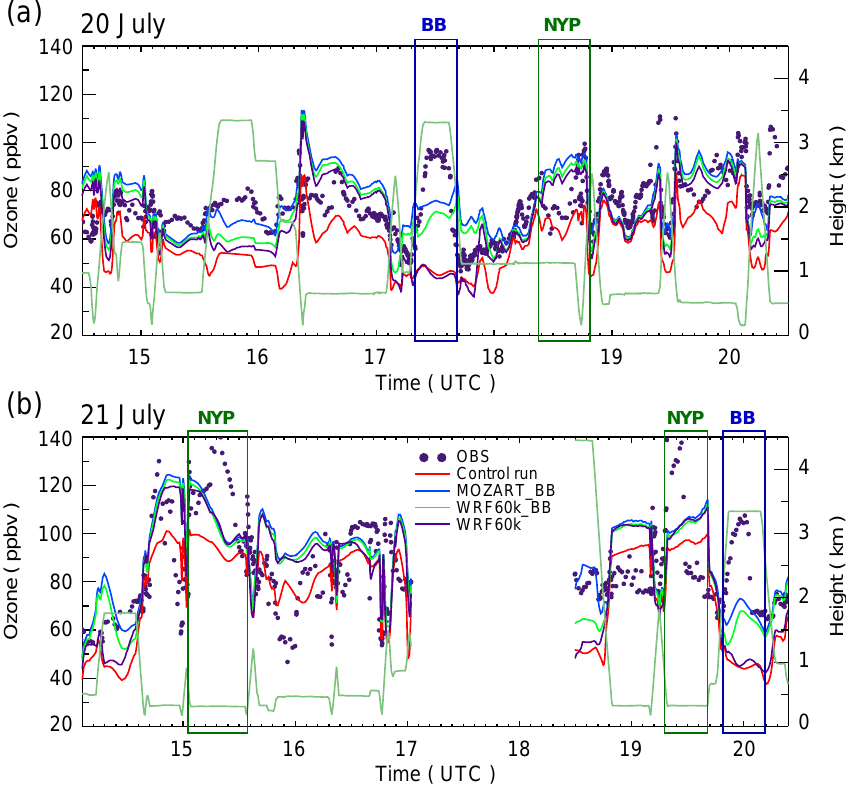
Fig. 15. (a) Observed and simulated O 3 mixing ratios along the WP-3D flight tracks on (a) 20 July and (b) 21 July. “NYP” and “BB” denote NYC urban plumes and biomass-burning plumes as in Figs. 4 and